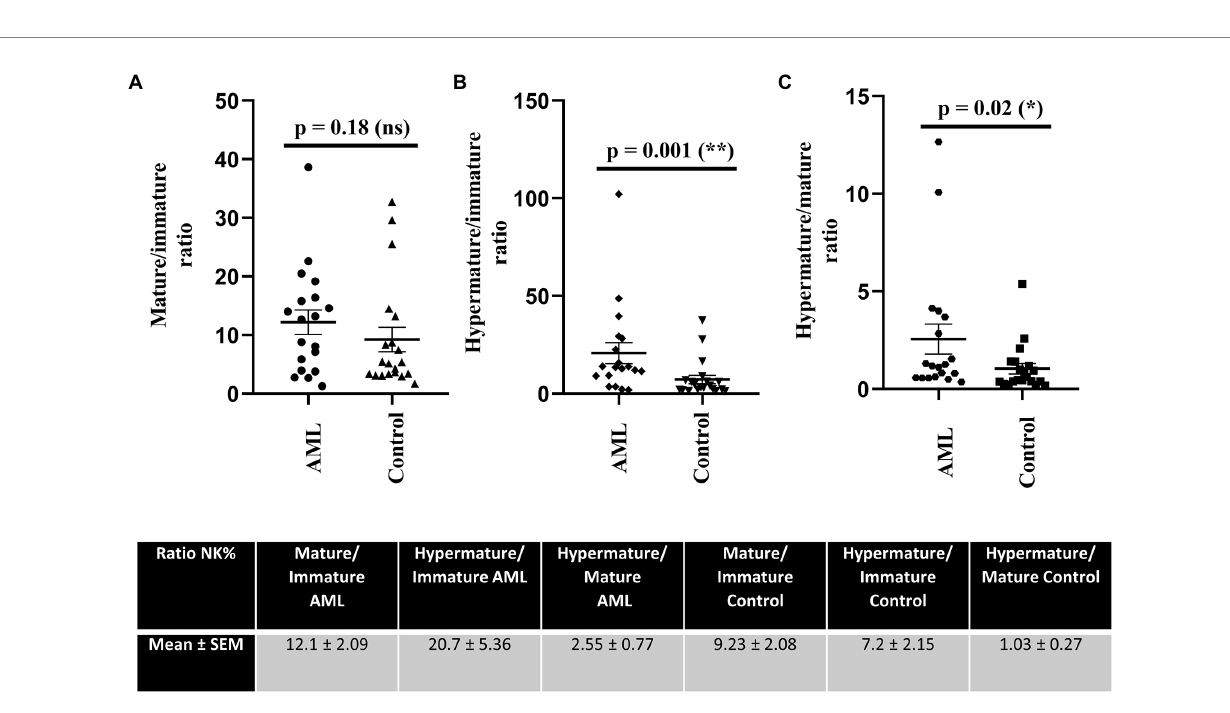
FIGURE 4 Ratios of NK cell percentages in each of the 3 maturation subsets for AML ( n = 19) and healthy control ( n = 20) cases. NK cells ratios for (A) mature to immature, (B) hypermature to immature, (C) hypermature to mature subsets in AML and healthy control individuals. Data is presented as scatter plots and the lines represent means ± SEM ( p = 0.001 (**); p = 0.02 (*); ns - not significant; D’Agostino and Pearson normal distribution test was not passed; unpaired Mann–Whitney test). Table shows mean ± SEM of ratios between mature and immature subpopulations, hypermature and immature subpopulations and hypermature and mature subpopulations in the AML and healthy control